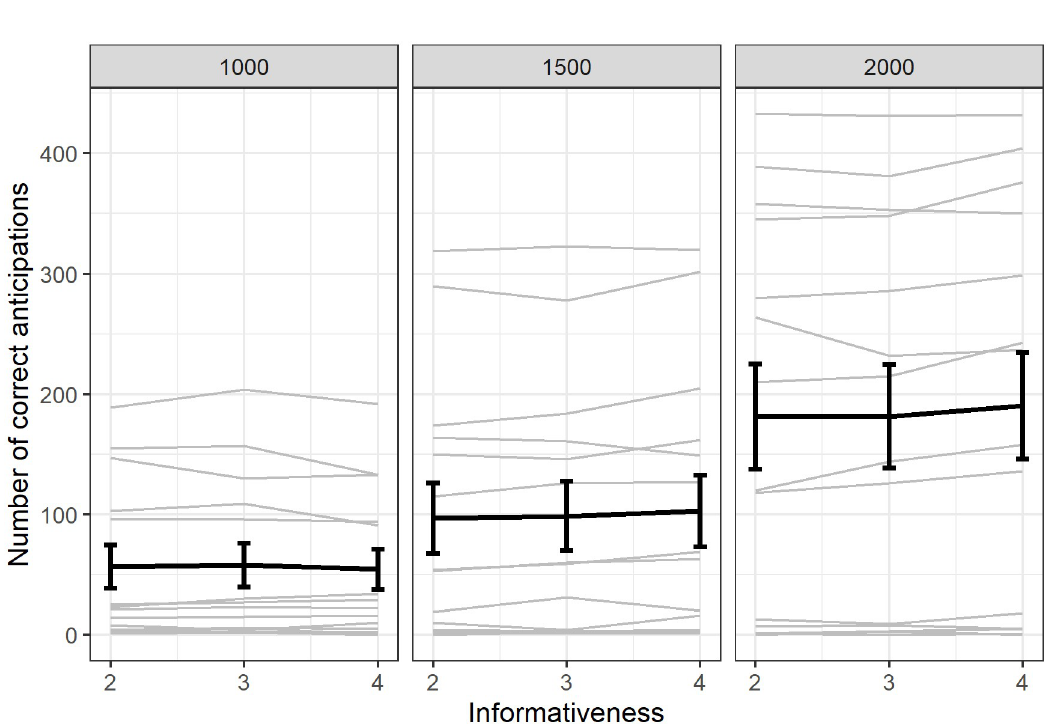
Fig 6. Number of anticipations depending on informativeness and delay. Individual responses (light grey) with group average (error bars represent standard error).